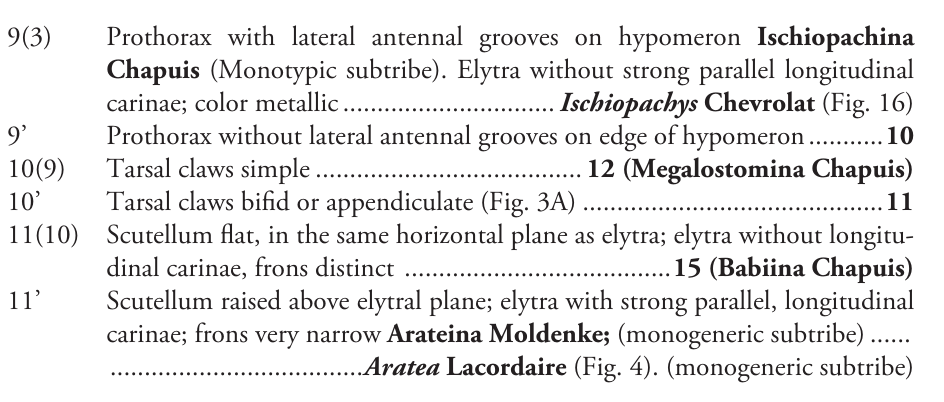
6’ Pronotum with or without tubercles, but never with six longitudinal, fan-like 7(6) Head not completely retracted into the prothorax; mandibles in males larger than in females; intercoxal prosternal process strongly and abruptly constrict- ed behind anterior margin; prosternal process more than 3/4 as long as inter- coxal prosternal process (Fig. 2H) … Pseudochlamys Lacordaire (Fig. 33) 7’ Head completely retracted into prothorax; mandibles in males as large as in females; intercoxal prosternal process gradually constricted at about 2/3 of its Males without spines or spinulae on ventrite I; antennomere V nearly as long as VI; elytral suture crenulation usually incomplete ( i.e. , suture entire imme- Males with spines or spinulae on ventrite I; antennomere V much shorter than